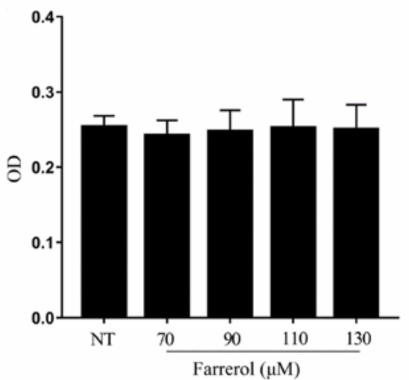
Figure 7. Effects of farrerol on the cell viability of mouse mammary epithelial cells (mMECs) cultured with different concentrations of farrerol (70, 90, 110 and 130 µ M). MMECs viability were determined by CCK-8 assay. Data are presented as mean ± SEM ( n =